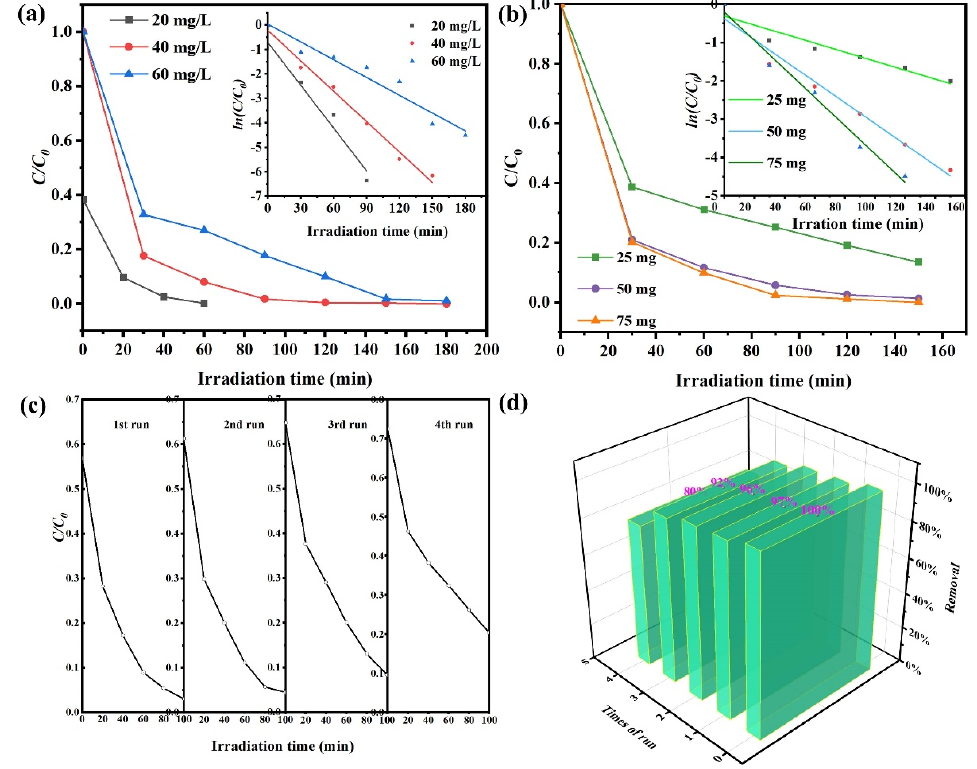
Figure 7. ( a ) Degradation effects and kinetic curves at different MB concentrations (n(H 2 O 2 ) = 20 mmol, m(cellulose/50%NiFe 2 O 4 − CA − 600 °C) = 50 mg, pH = 11). ( b ) Degradation effects and kinetic curves at different catalyst concentrations (n(H 2 O 2 ) = 20 mmol, C 0 (MB) = 40 mg/L, pH = 11). ( c ) Time change diagram of cyclic experiments. ( d ) Bar chart of run efficiency (m(cellu- lose/50%NiFe 2 O 4 − CA − 600 °C) = 20 mg, C (MB) = 20 mg/L, n(H 2 O 2 ) = 20 mmol, pH =